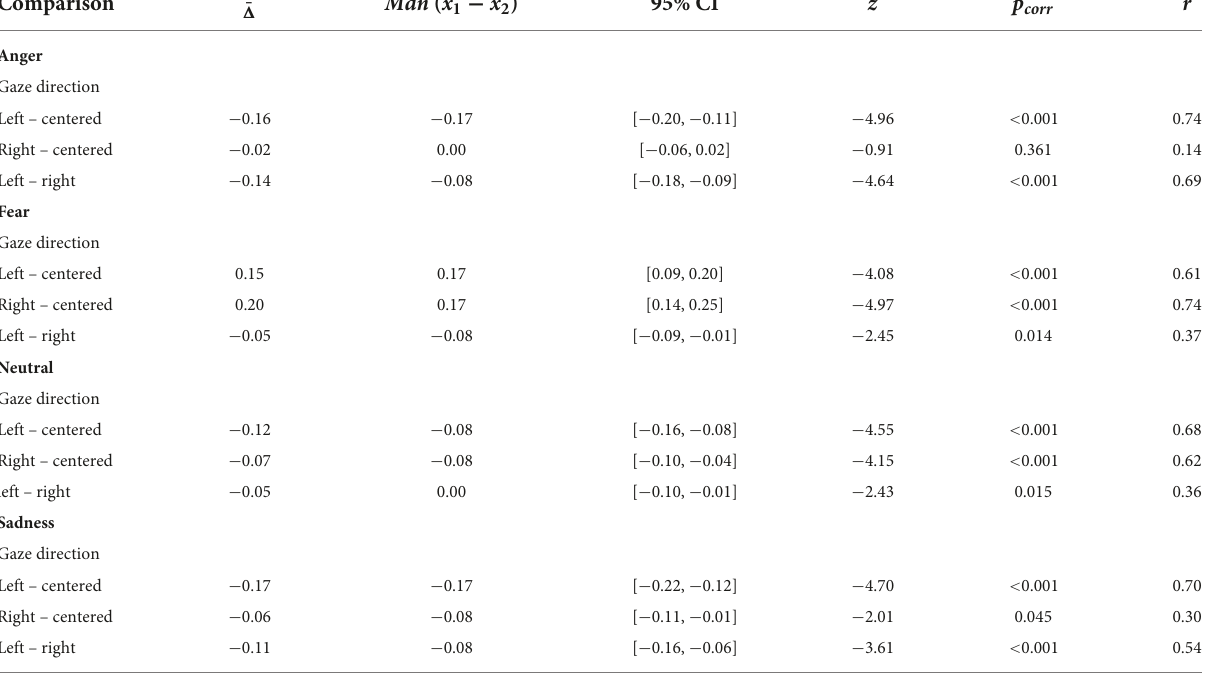
TABLE 3 Experiment 2: Results of the Wilcoxon signed-rank tests for correct emotion recognition (percentages given as decimals) ( N = 45).